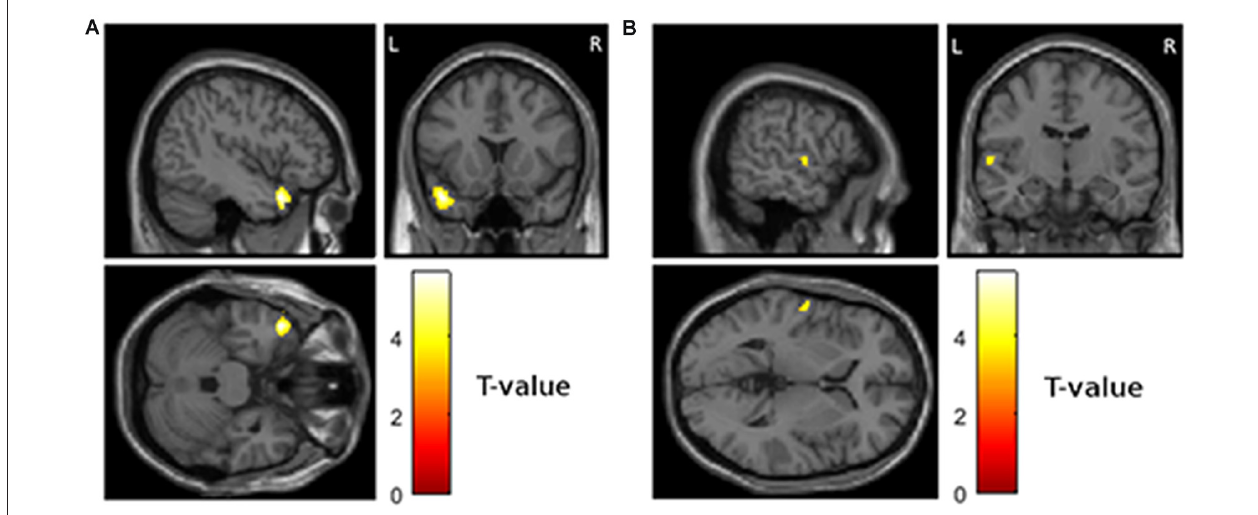
FIGURE 1 | Areas showing a cross-sectional relationship between atrophy and magnitude of depressive symptoms at visit 1 ( p < 0.001 uncorrected and more than 50 contiguous voxels in a cluster). (A) Left temporal pole, MNI coordinates of peak voxel − 44, 16, 28 (B) left superior temporal gyrus, MNI coordinates of peak voxel − 58, − 10,